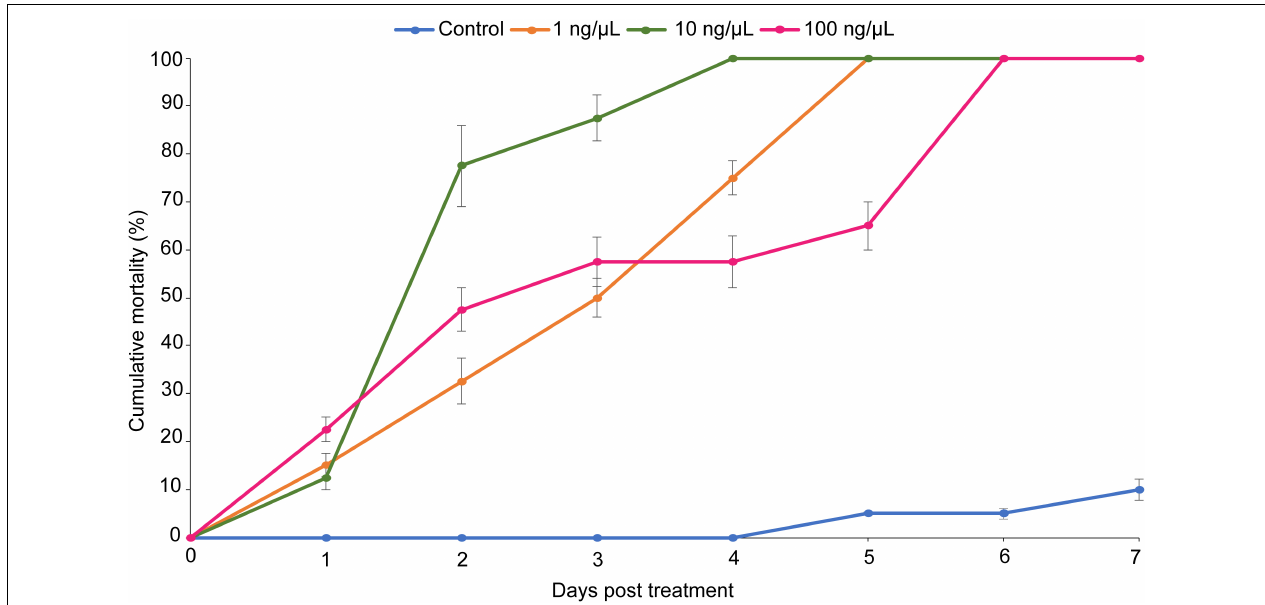
FIGURE 7 | Cumulative larval mortality of Tuta absoluta induced by three concentrations (1, 10, and 100 ng/ µ L) of ( Z )-jasmone.